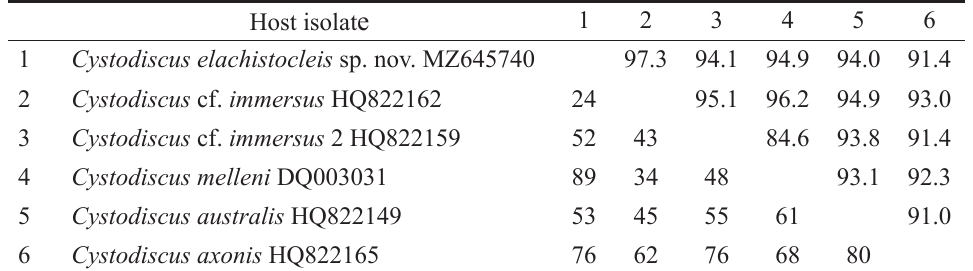
Table 3. The similarity in SSU rDNA sequences of Cystodiscus spp. The upper triangle shows the percentage of nucleotide similarity, while the lower triangle shows the actual nucleotide